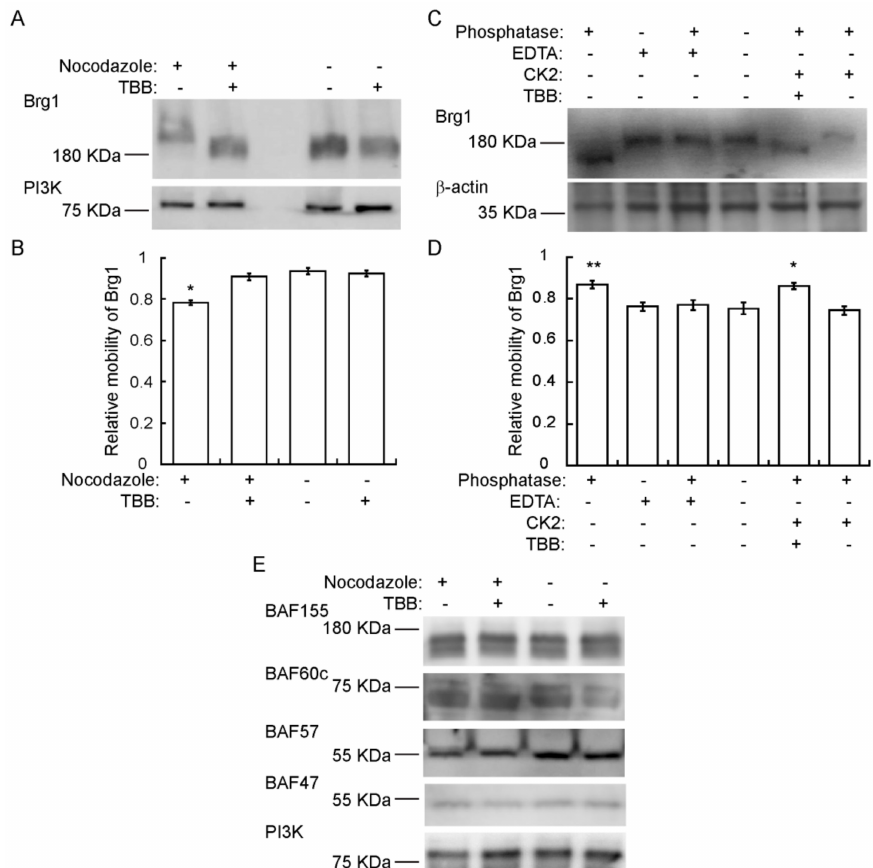
Figure 4. Brg1 is phosphorylated by CK2 during mitosis. Primary myoblasts were treated or not with 500 nM nocodazole and 10 µ M TBB, as indicated. Samples were separated in a 5% SDS-PAGE supplemented with Phos-Tag ™ . ( A ) Representative Western Blot of the CK2-mediated shift in Brg1 mobility in myoblast cultures enriched for mitotic cells. PI3K levels were monitored as a loading control. ( B ) Quantification of the average relative mobility of Brg1 in the gel in response to nocodazole treatment and CK2 inhibition ( n = 3). ( C ) Representative Western Blots following an in vitro dephosphorylation / phosphorylation assay on Brg1 in primary myoblast extracts from cells treated as indicated. β -actin was monitored as a control. ( D ) Quantification of the average relative mobility of Brg1 in the gel in response to the treatments indicated in ( C ) ( n = 3). ( E ) Representative Western Blots showing no easily discernible changes in mobility for BAF155, BAF60c, BAF57, or BAF47 in primary myoblast extracts from cells treated as indicated. PI3K was used as a loading control. Three independent biological replicates were performed for each experiment. Statistical significance was calculated by a t-test vs. the untreated control. * p < 0.05; ** p <